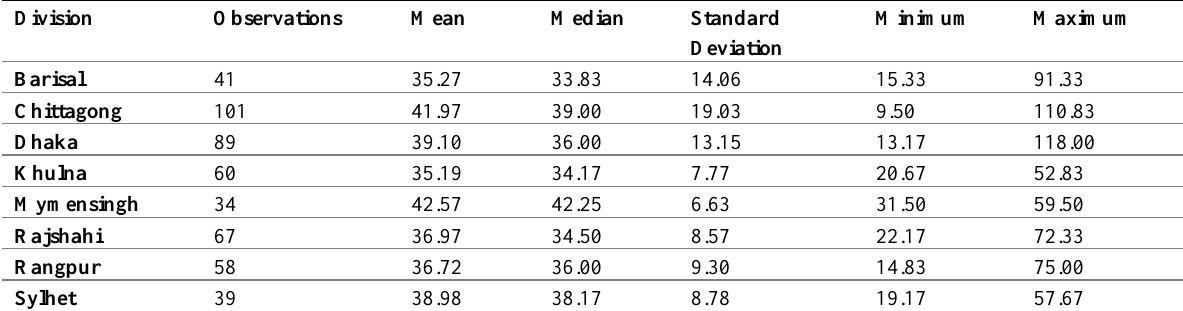
Table 3: Descriptive Statistics (Students per Teacher in Primary and Equivalent Institutions) Division